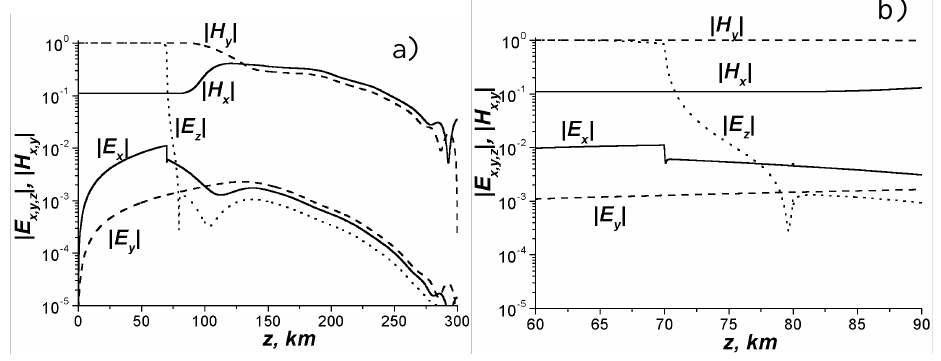
Fig. 6. A dependence of components | E x,y,z | and | H x,y | on the vertical coordinate z under 2 =30 ◦ (nighttime) (a) . The detailed dependence for the heights 60 ÷ 90km (b) . Fig.6. A dependence of components |E x,y,z | and |H x,y | on the vertical coordinate z under Q Fig.6. A dependence of components |E | and |H | on the vertical coordinate z under Q x,y,z x,y = 30º (nighttime) (a). The detailed dependence for the heights 60 ‚ 90 km (b). = 30º (nighttime) (a). The detailed dependence for the heights 60 ‚ 90 km (b).